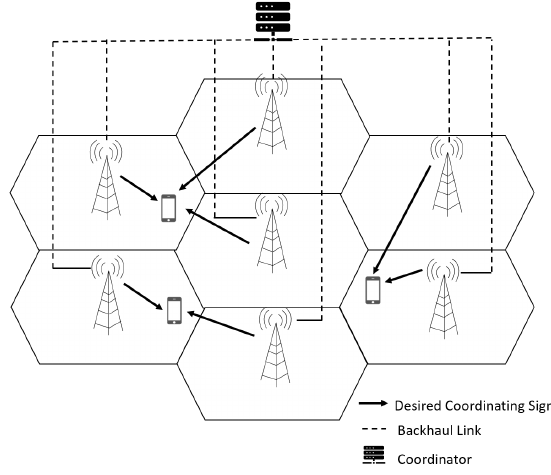
Figure 1. Downlink JP-CoMP configuration system with seven